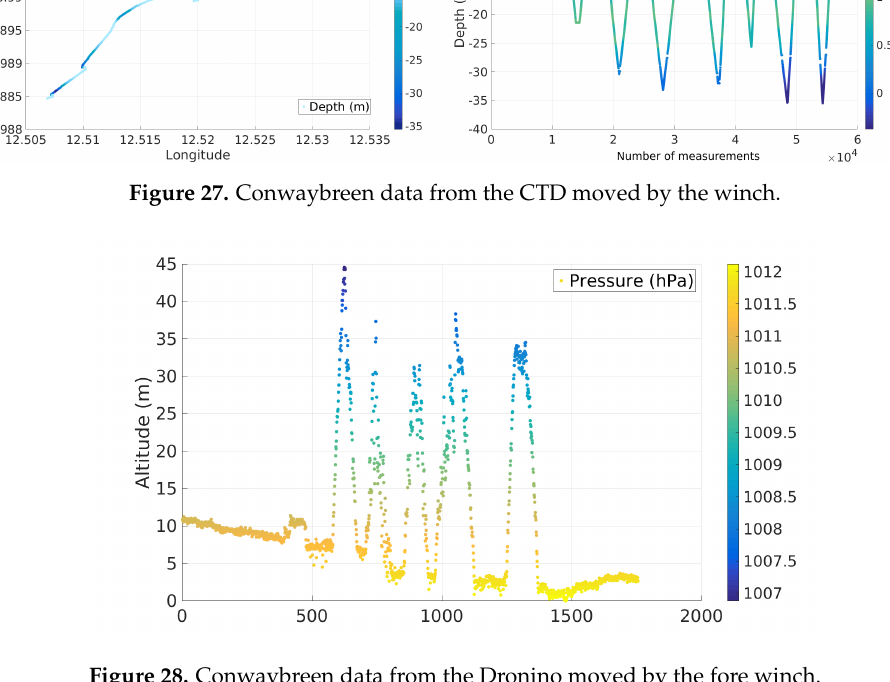
Figure 28. Conwaybreen data from the Dronino moved by the fore winch.